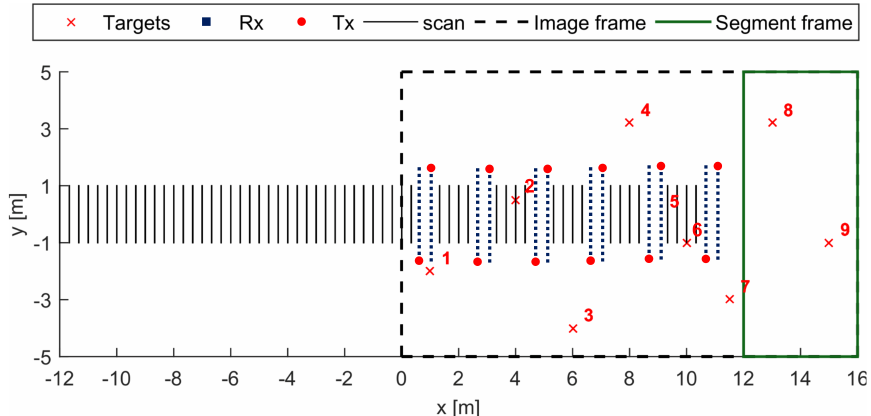
Figure 3. The last image segment is highlighted in green and the relevant full aperture measurements to be exploited in coherent combining are indicated in blue (the positions of transmitters and receivers are not drawn to scale within the image